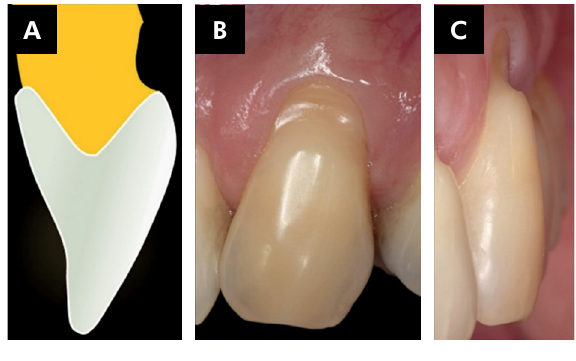
Figure 2. Schematic view of the A+ tooth surface. A non-carious cervical lesion (NCCL) is associated with gingival recession (GR) affecting only the root surface. The cementoenamel junction (CEJ) and the crown were not involved (a). Facial view of a combined defect (CD) with recession type 1 GR and A+ NCCL. Note the CEJ is still present (b). Lateral view of the same CD. Note the presence of the CEJ (c).